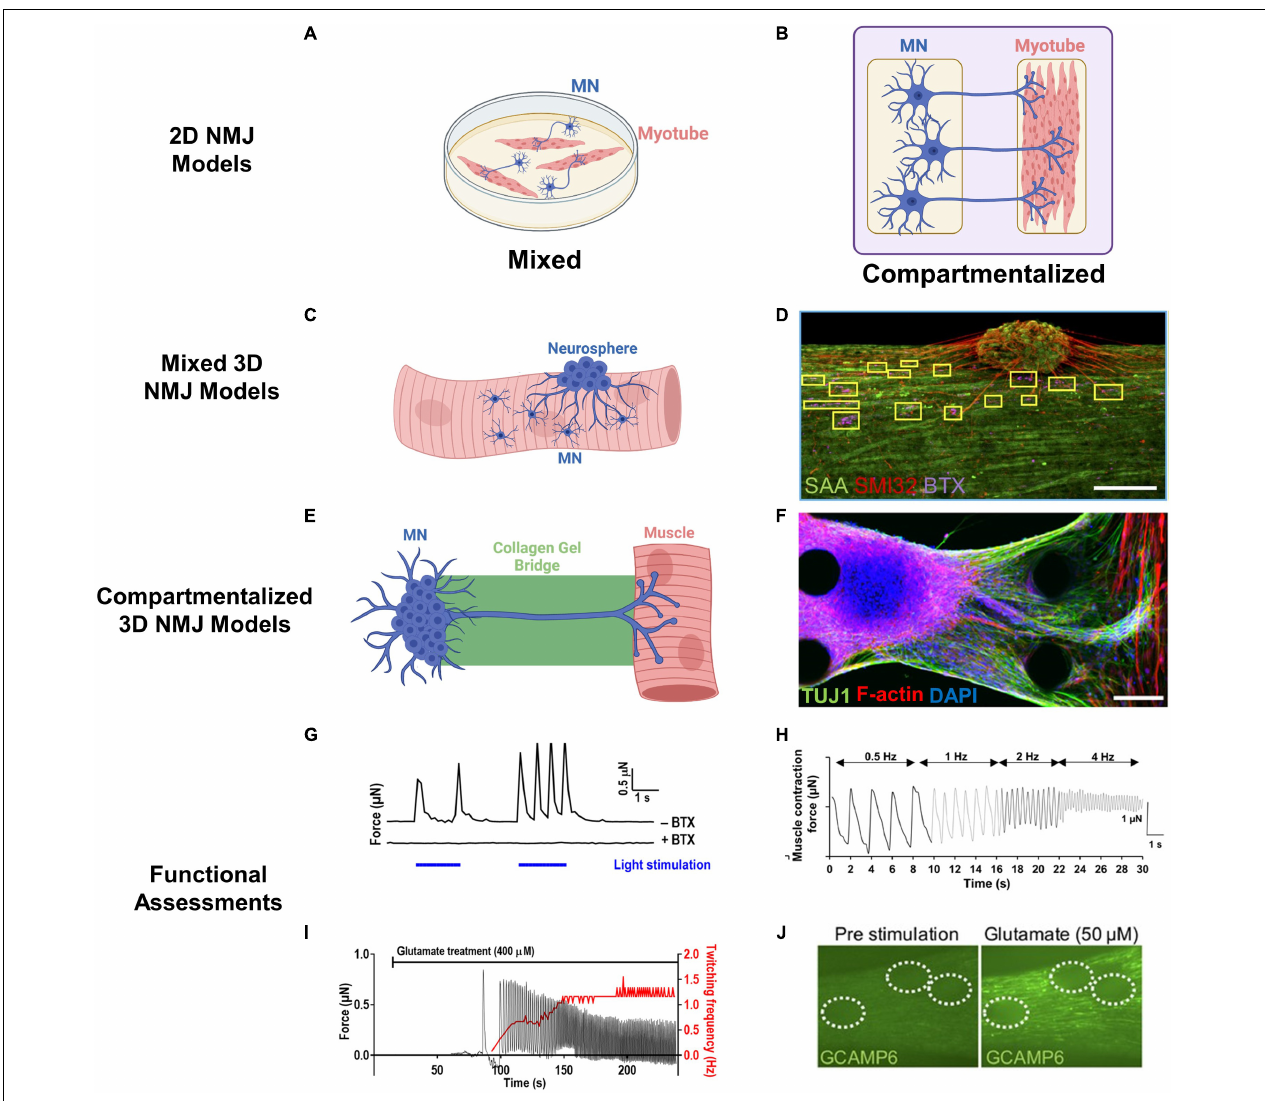
FIGURE 4 | Engineered NMJ models. (A,B) Schematics of 2D NMJ co-culture models in mixed (A) and compartmentalized (B) configuration. (C) Mixed 3D NMJ co-culture systems incorporate MNs or neurospheres into SkM during 3D tissue formation. (D) Representative mixed 3D NMJ model with immunofluorescent staining of muscle sarcomeres (SAA), neurite extensions (SMI32), and acetylcholine receptors (BTX). Scale bar, 200 µ m (Bakooshli et al., 2019; Copyright 2019, eLIFE ). (E) Compartmentalized 3D NMJ co-culture systems culture MNs and SkM in separate compartments bridged by an extracellular matrix gel to facilitate axonal outreach and SkM innervation. (F) Representative compartmentalized NMJ model with immunofluorescent staining of neurite extensions (TUJ1) and myotubes [filamentous (F)-actin]. Scale bars, 100 µ m (Osaki et al., 2018; Copyright 2018, Science Advances ). (G) Example of optogenetic control of 3D NMJ models through blue light illumination (blue bars) of ChR2 H 134 R -HBG3-MN neurospheres inducing contraction in muscle ( y -axis) as measured by pillar displacement within a microfluidic system. Administration of α -bungarotoxin (BTX) prevented MN-induced contractions (Uzel et al., 2016; Copyright 2016, Science Advances ). (H) Example of muscle contraction induced by electrical stimulation of MNs at varying frequencies (0.5–4 Hz) (Osaki et al., 2018; Copyright 2018, Science Advances ). (I) Representative recording of contractile force ( y- axis) in 3D SkM-MN co-culture induced by glutamate stimulation of neurospheres (Uzel et al., 2016; Copyright 2016, Science Advances ). (J) Representative recording of glutamate-induced Ca 2 + transients in 3D SkM-MN co-culture with muscle-specific expression of GCaMP6 reporter. MN neurospheres are encircled by dashed lines (Bakooshli et al., 2019; Copyright 2019, eLIFE